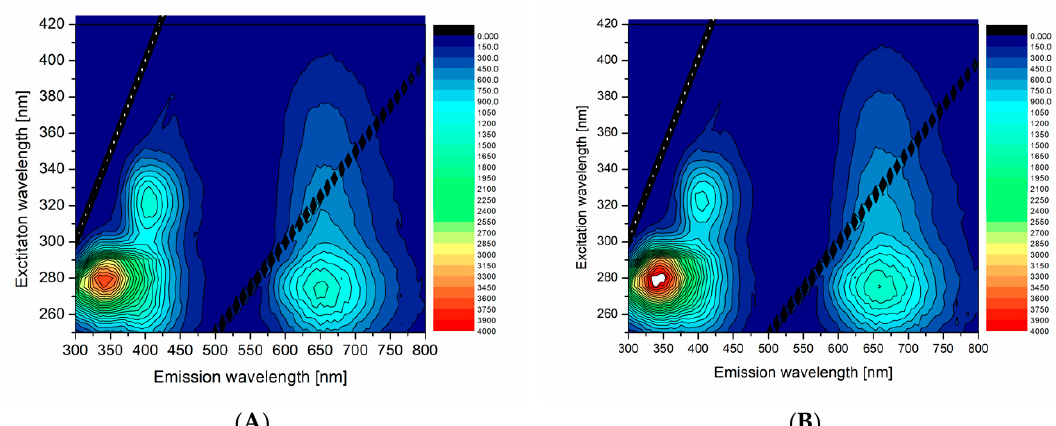
Figure 3. 3D excitation-emission maps of ( A ) 98BSA-AuNCs and ( B ) df98BSA-AuNCs. Note: Strong Rayleigh scattering first- and second-order maxima are visible as straight lines in these 3D maps and represent artifacts, which do not belong to the samples.